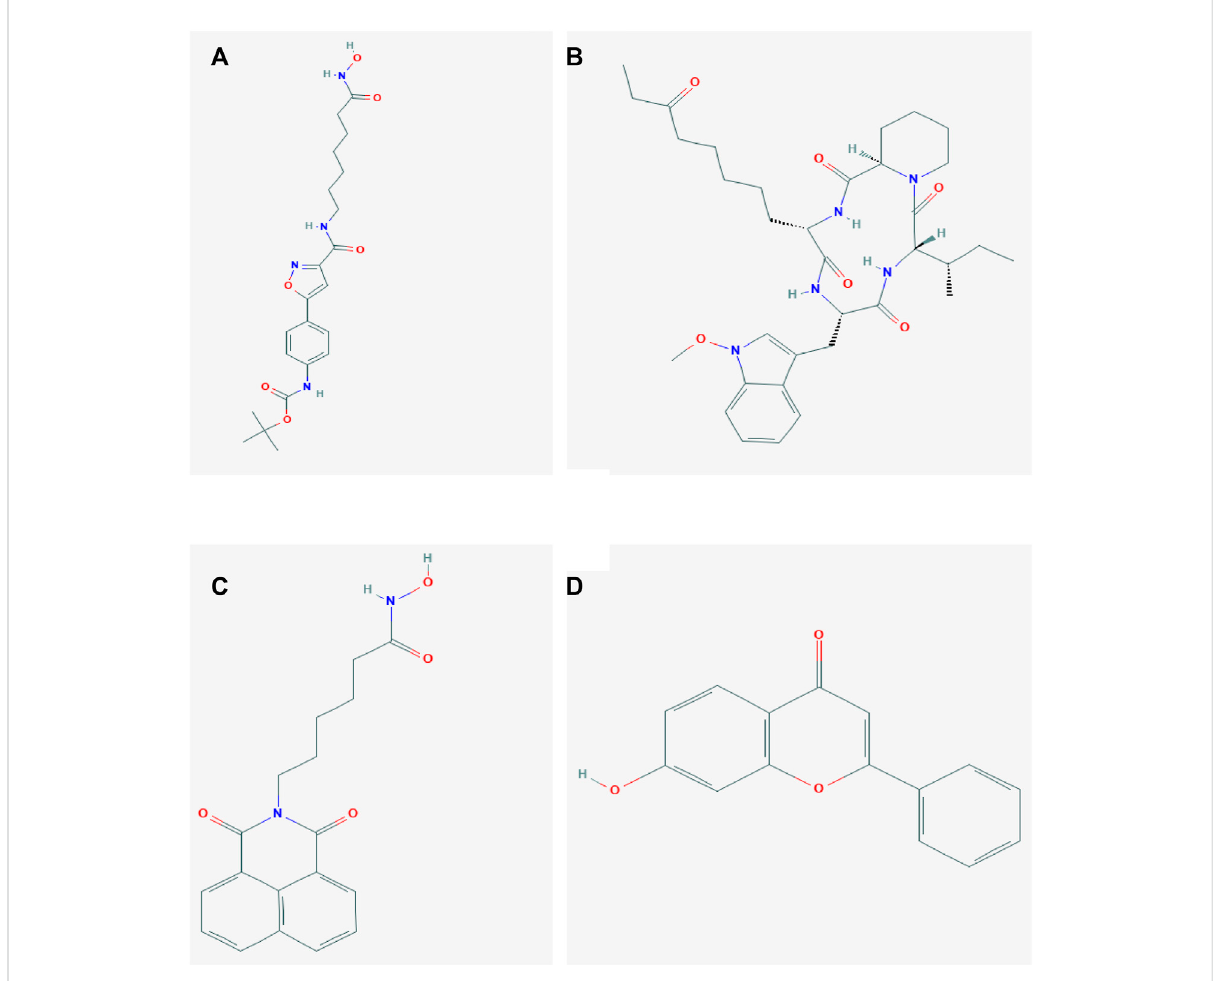
FIGURE 6 Chemical structures of the four molecules. (A) Structure diagram of ISOX. (B) Structure diagram of apicidin. (C) Structure diagram of scriptaid. (D) Structure diagram of